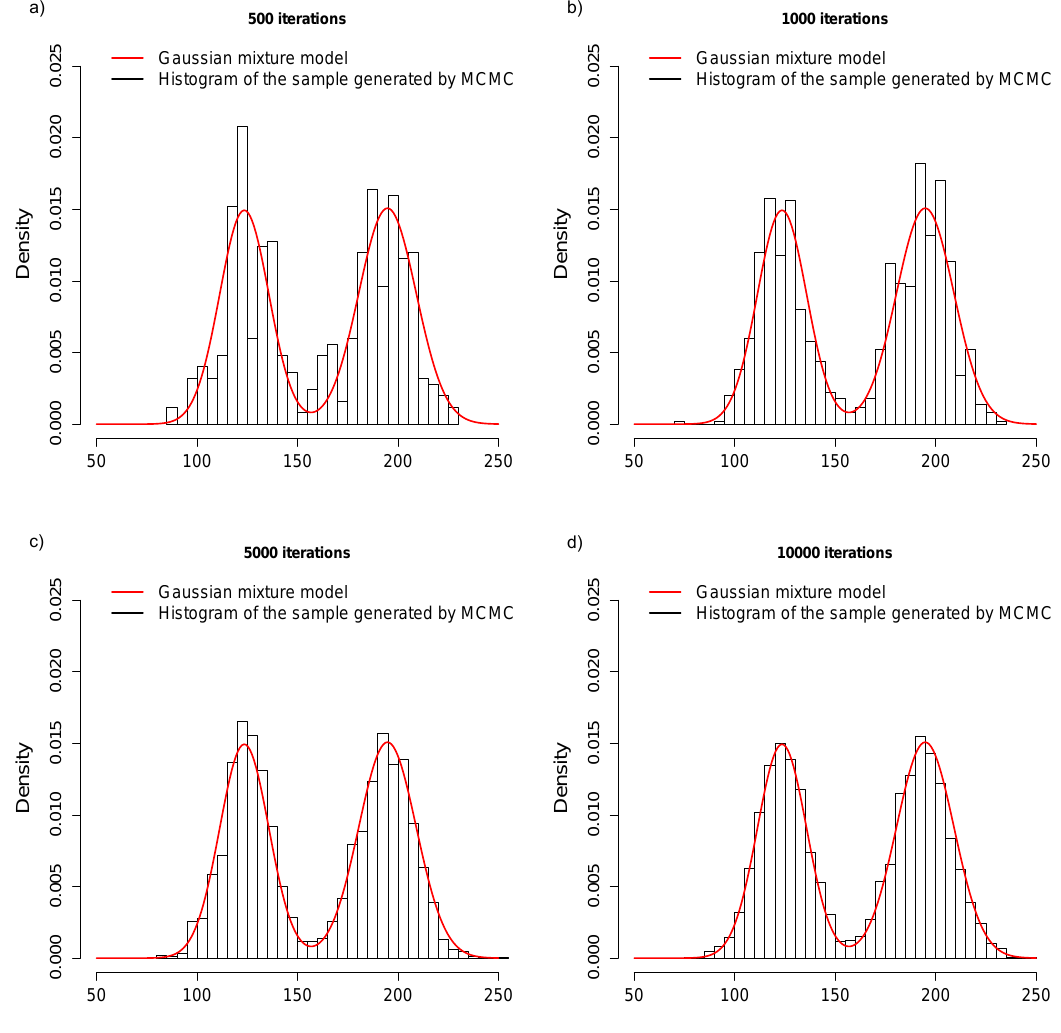
Figure 9. Histograms of the samples generated by MCMC from the density obtained by the Gaussian mixture model: ( a ) 500 iterations. ( b ) 1000 iterations. ( c ) 5000 iterations. ( d ) 10,000